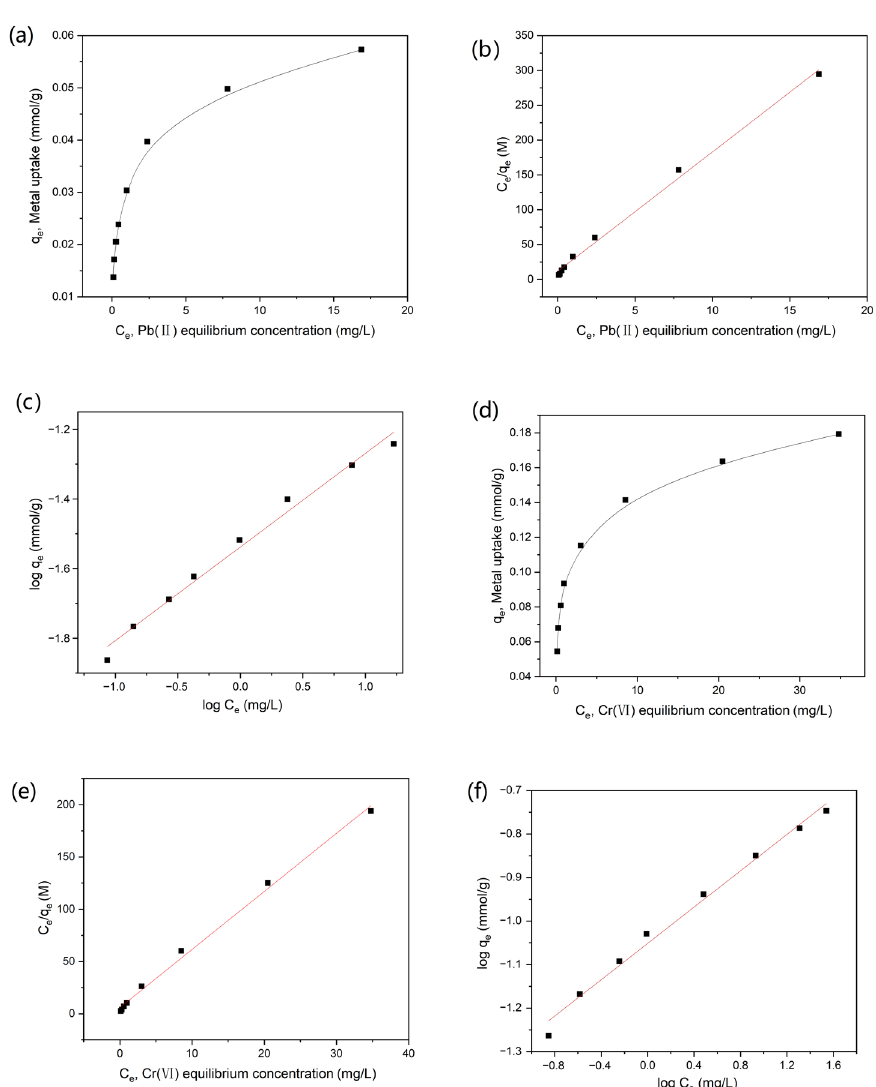
Figure 3. ( a – c ): The adsorption isotherm of resulted in AC to Pb(II) by equilibrium concentration ( a ), Langmuir equation (linear form, ( b )) and Freundlich equation (linear form, ( c )); ( d – f ): the adsorption isotherm of resulted from AC to Cr(VI) by equilibrium concentration ( d ), Langmuir equation (linear form, ( e )), and Freundlich equation (linear form, ( f )).